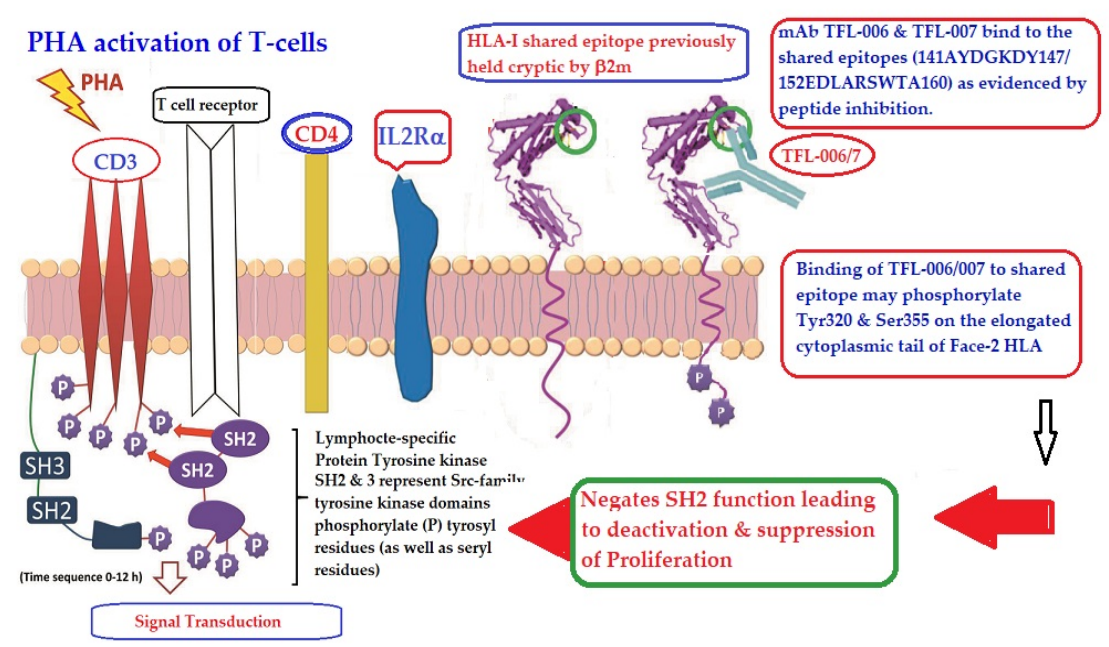
Figure 13. An illustration of the possible mechanism of suppression of PHA activated T ‐ cells mediated by mAbs directed against shared epitopes exposed in the Face ‐ 2 of almost all alleles of HLA ‐ I . The figure shows CD3/T cell receptor (TCR)/CD4 on the bi ‐ layered lipid membrane on the T ‐ cells upon activation (Yellow complex arrow). Phosphorylation of the cytoplasmic domain of CD3 is induced by Lymphocyte ‐ specific protein tyrosine kinase (LCK). SH represents Scr ‐ family LCK. They phosphorylate the tyrosyl (even seryl) domain of the cytoplasmic tail of CD3. This event leads to activation of transcription factors and transcription cell ‐ surface molecules such as IL2R α and Face ‐ 2. Importantly, the HLA ‐ I open conformers devoid of β 2m (Face ‐ 2) expose unique epitopes shared by almost all HLA ‐ I alleles. It is the site recognized by TFL ‐ 006 and TFL ‐ 007. It is postulated that the binding of these specific mAbs to the epitopes on the Face ‐ 2 may initiate phosphorylation of the elongated cytoplasmic tail. The elongated cytoplasmic tail results in the exposure of cryptic tyrosyl residue at position 320 [137–139] and serine at position 35 [140]. This leads to transduction that initiates dephosphorylation of the cytoplasmic domain of CD3, resulting in suppression of activation of T ‐ cells. Evidently, the T ‐ cell activating CD3 ‐ phosphorylation can be reversed.